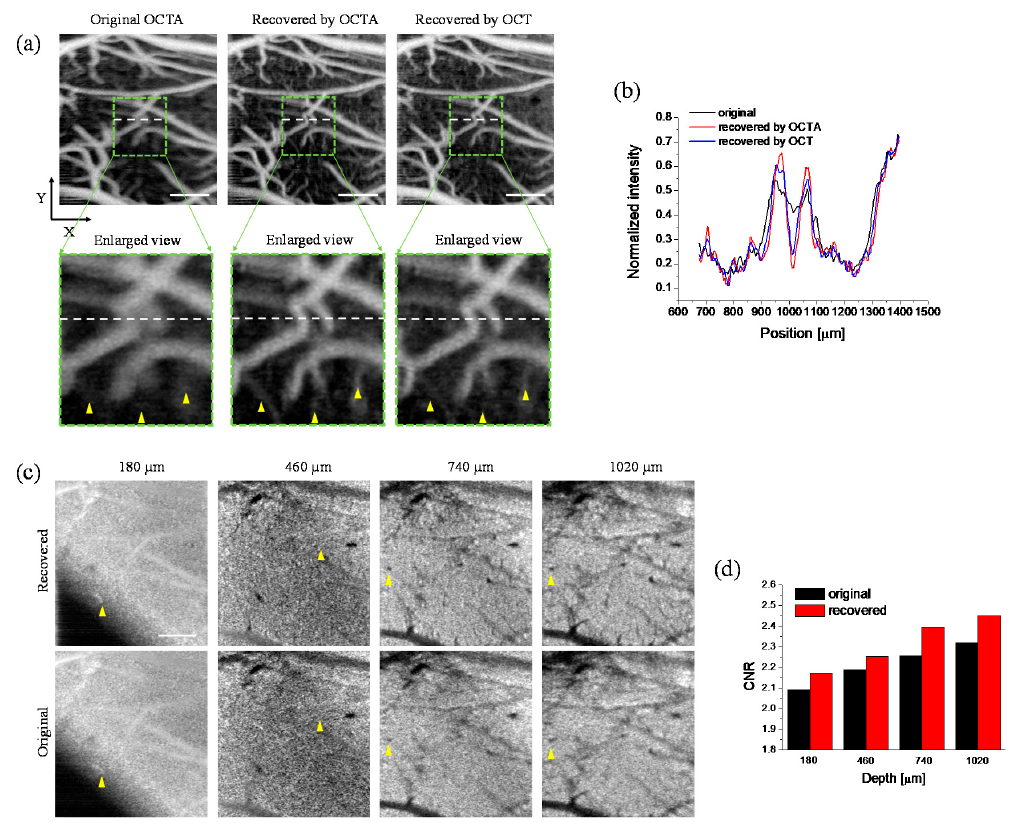
Figure 5. Comparison of en face maximum intensity projections (MIPs) of the original and recovered OCTA/OCT images obtained at specific depths (0–280 µm for OCTA image, and 180, 460, 740, and 1020 um for OCT images). ( a ) En face MIPs and an enlarged view of original and recovered OCTA images (recovered by OCTA or OCT images), respectively. ( b ) Line profiles of white dotted lines in ( a ). ( c ) Recovered and original OCT images at specific depths. ( d ) Contrast to noise ratio (CNR) of the OCT images in ( c ). Yellow triangles show noticeable the contrast change between images. Scale bar is 500 µm.